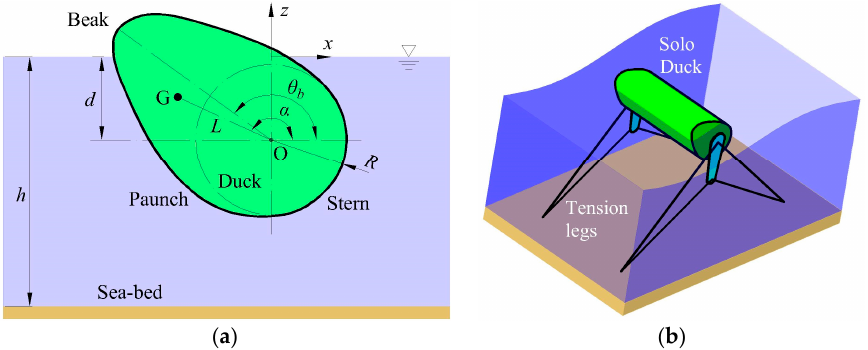
Figure 1. Geometry of the solo Duck wave energy conversion (WEC): ( a ) plane view of the Duck cross section; and ( b ) isometric view of the taut mooring configuration for a Duck with fixed pitching axis in head on waves.